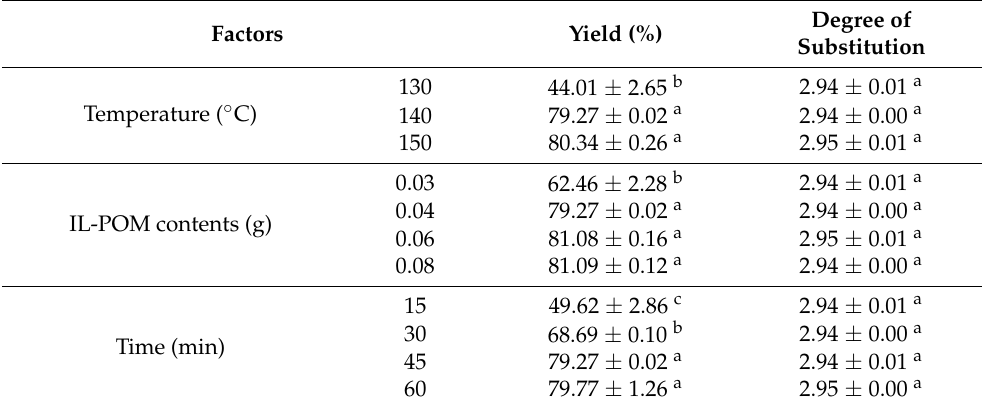
Table 1. Effects of reaction temperature, IL-POM content, and reaction time on the yield and degree of substitution of